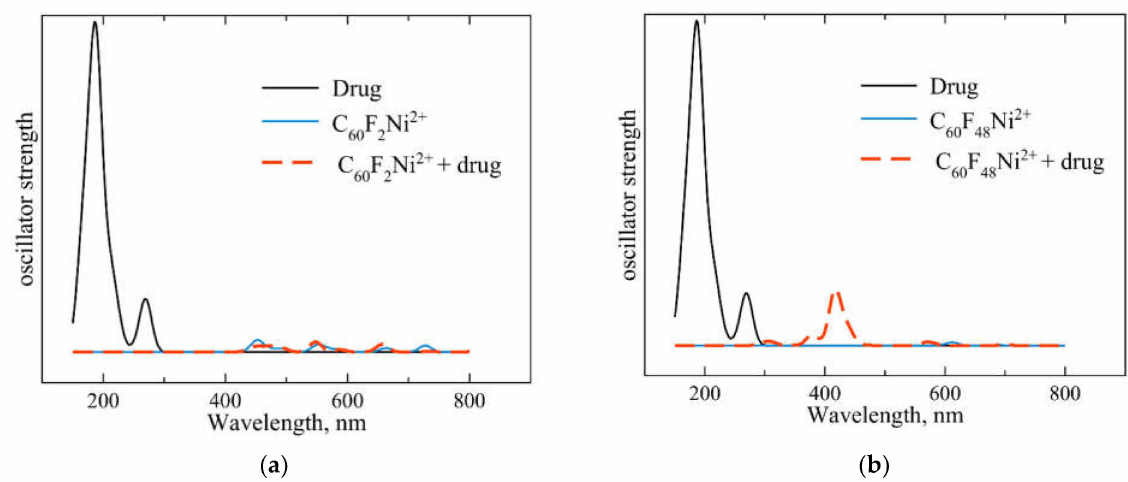
Figure 5. Ultraviolet and visible spectra of ( a ) chloroquine drug (black line), C 60 F 2 Ni 2+ carrier (blue line) and carrier + loaded drug complex (red dashed line). ( b ) The same spectra for high-fluorinated C 60 F 48 Ni 2+ carrier loaded with chloroquine. The calculated wavelengths corresponding to the transitions are broadened by Gaussian curves with σ = 10